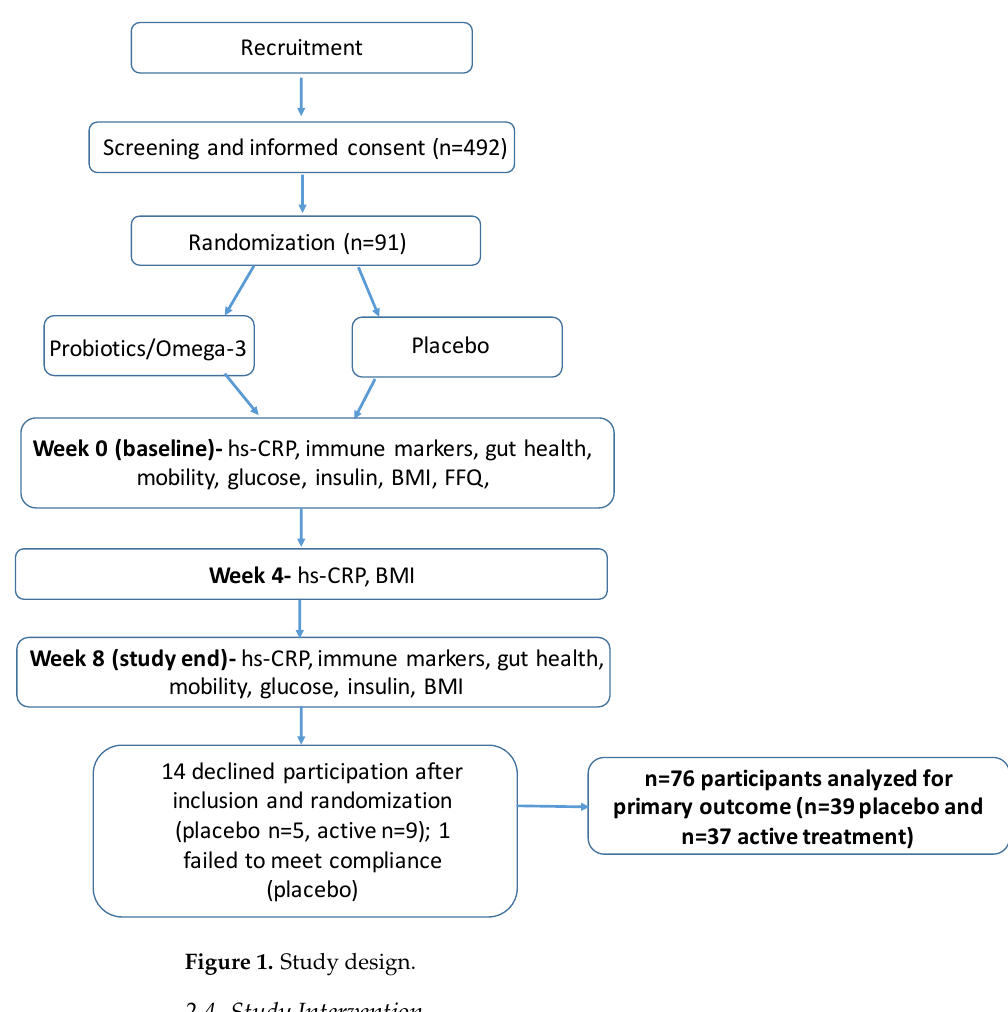
Figure 1. Study design.